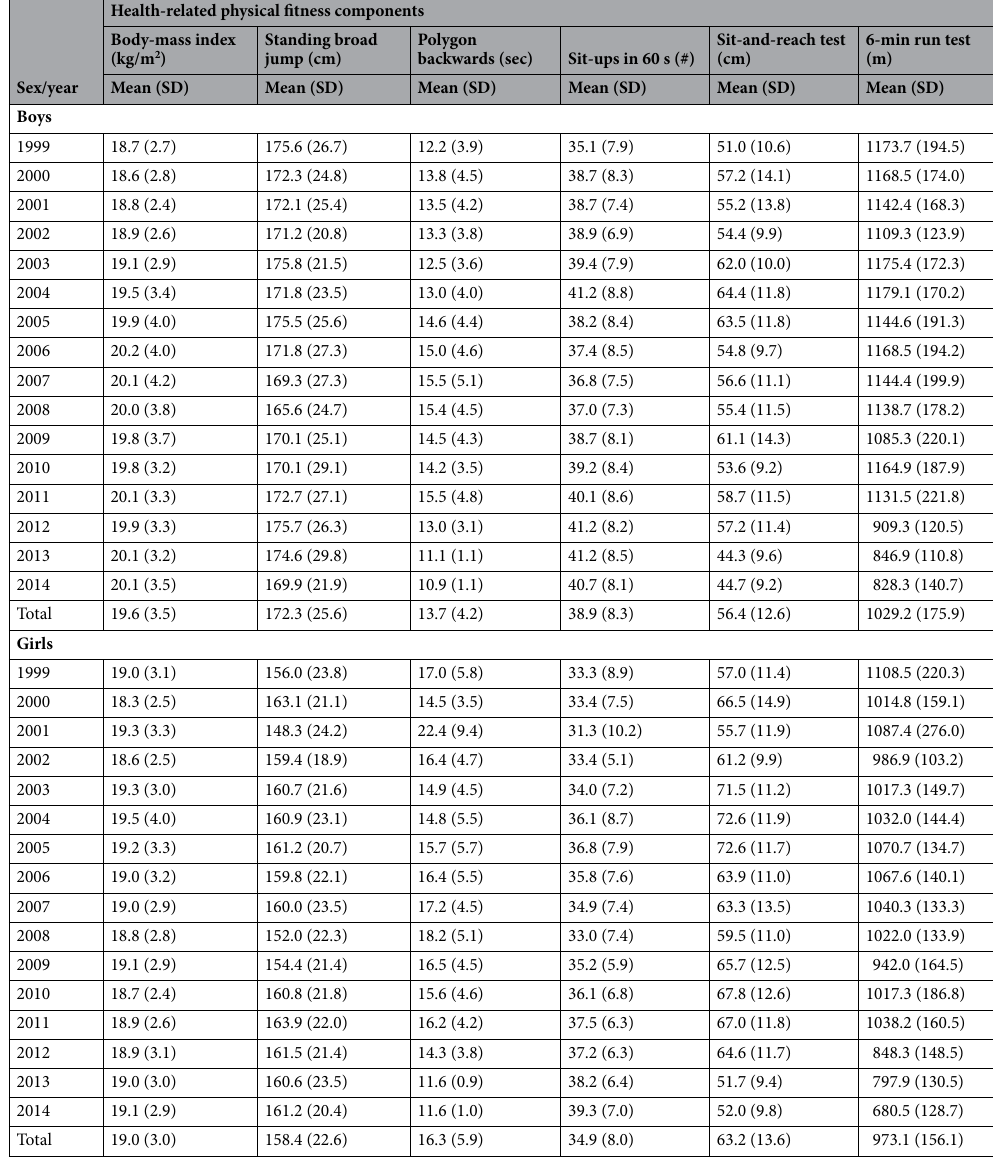
Table 1. Basic descriptive statistics of the study participants ( N =